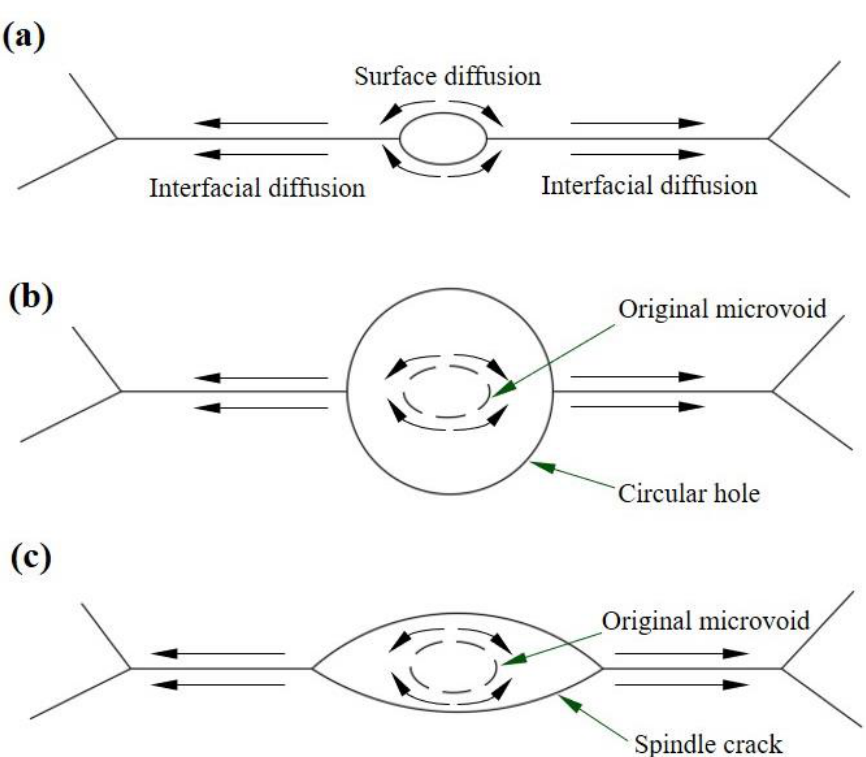
Figure 8. ( a ) The model of microvoid growing with diffusion; ( b ) the model of microvoid growing up into a circularshape cavity; ( c ) the model of microvoid growing up into a spindle shape